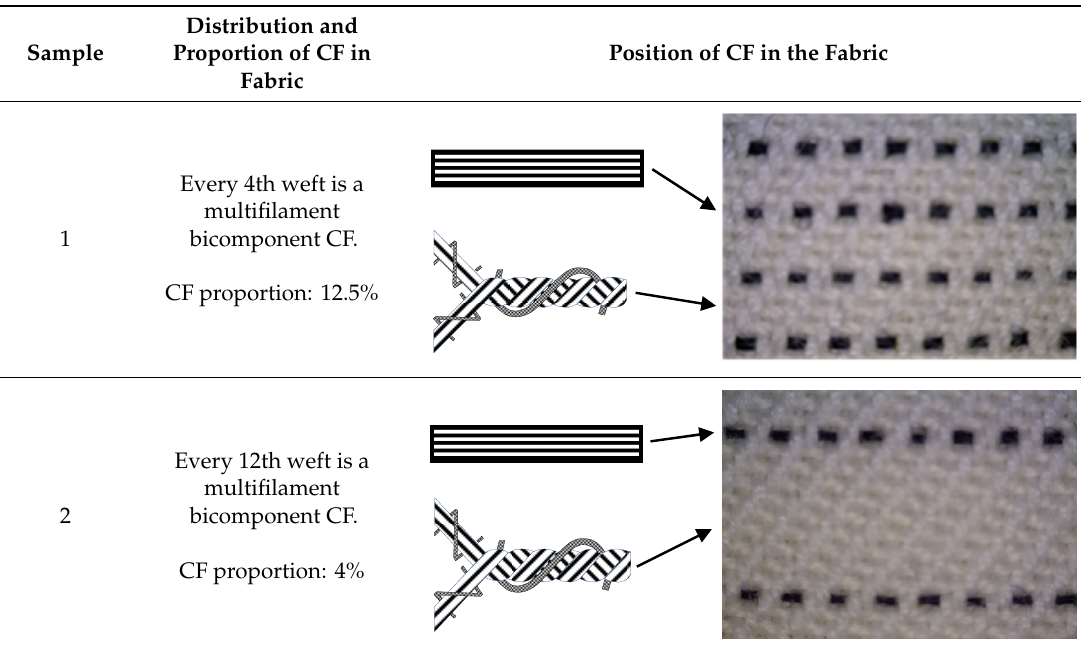
Table 2. Position and proportion of CF in woven fabric.